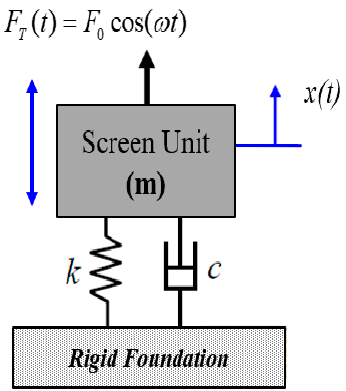
Figure 2. Single degree of freedom (DOF) vibration isolation model on rigid foundation.